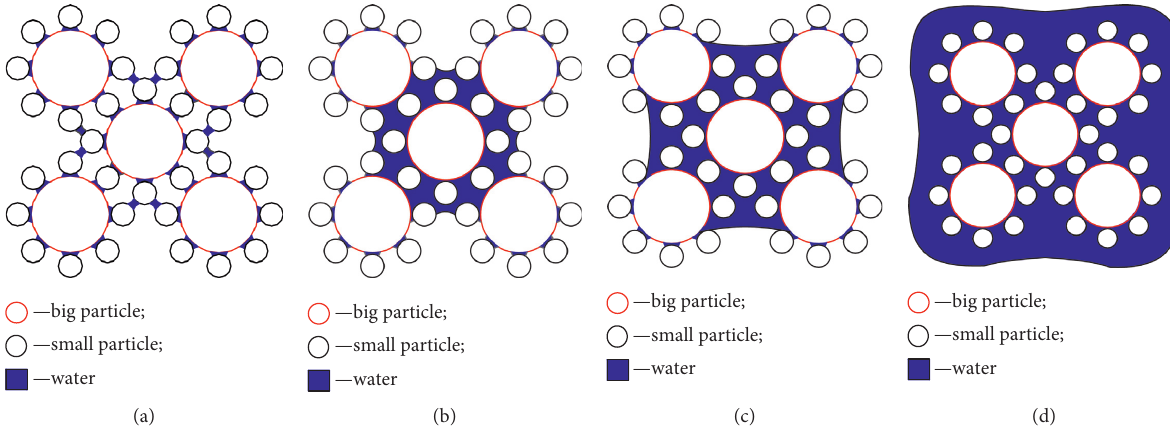
Figure 9: Shape of water-coal liquid bridge at different stages: (a) State I; (b) State II; (c) State III; (d) State IV. Table 5: Shape of liquid bridge and variation law of liquid bridge force with water content. Form of liquid bridge State Between large and small particles Between big